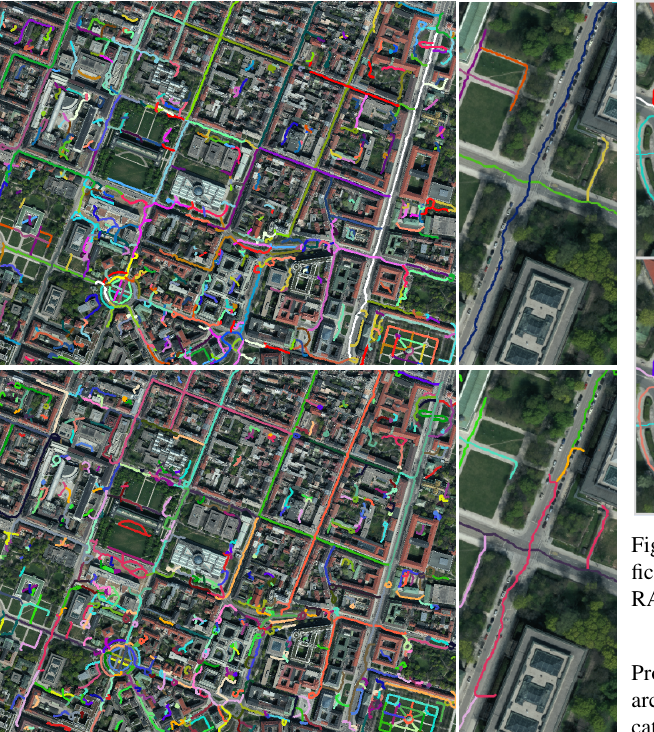
Figure 3: Results of chain forming with neighborhood searching function based on partial dominant directions (top) and on circle- fit + RANSAC (bottom), visualized for the complete dataset (left) and a for long street (right). The chains are given random, arbi- trary colors. Side roads were omitted.